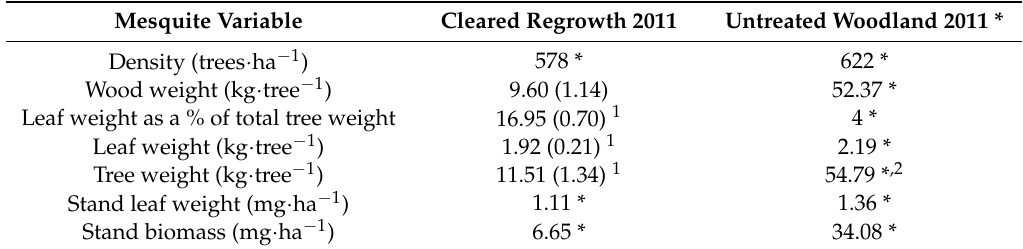
Table 2. Mesquite stand and individual tree data of regrowth trees in the cleared treatment and woodland trees in 2011. Asterisk indicates a projected value, based on leaf weight being 4% of total tree weight. Regrowth means are followed by standard error in parentheses. No statistics were provided for projected